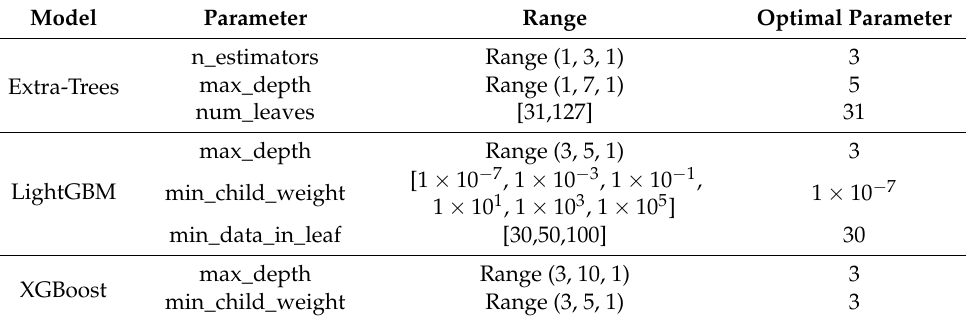
Table 8. Cont. Model